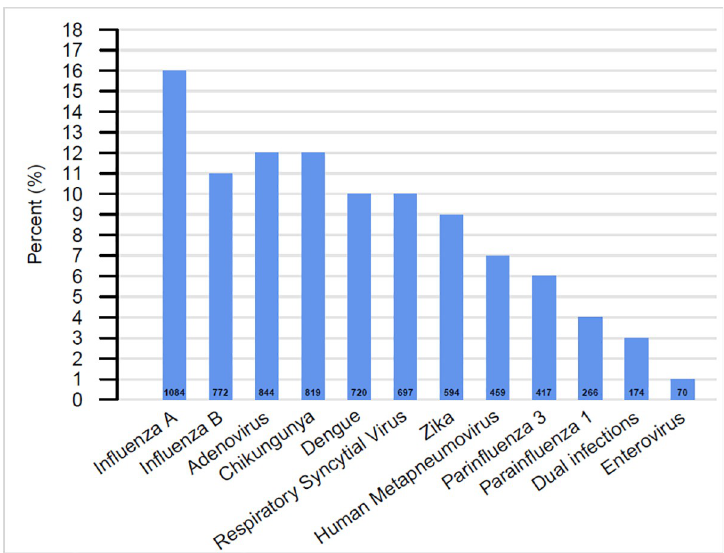
Fig 1. Overall distribution of viral etiology identified in pediatric patients, Sentinel Enhanced Dengue Surveillance System (SEDSS), Southern Puerto Rico, 2012–2018 (n = 6,916).